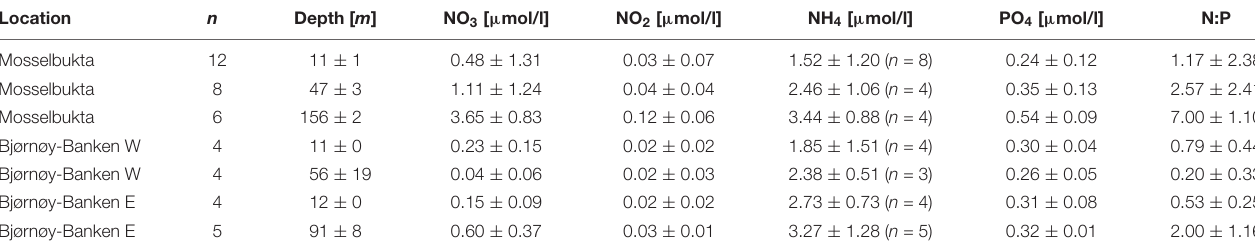
TABLE 2 | Dissolved inorganic nutrients along with Redfield N:P ratios in Mosselbukta and at Bjørnøy-Banken (W and E of the Polar Front) for surface waters and for bottom waters, averaged over the available CTD casts (bottom water stations complemented with water samples taken by JAGO; total number of considered samples per depth indicated in the second column; fewer samples for ammonium indicated in the respective